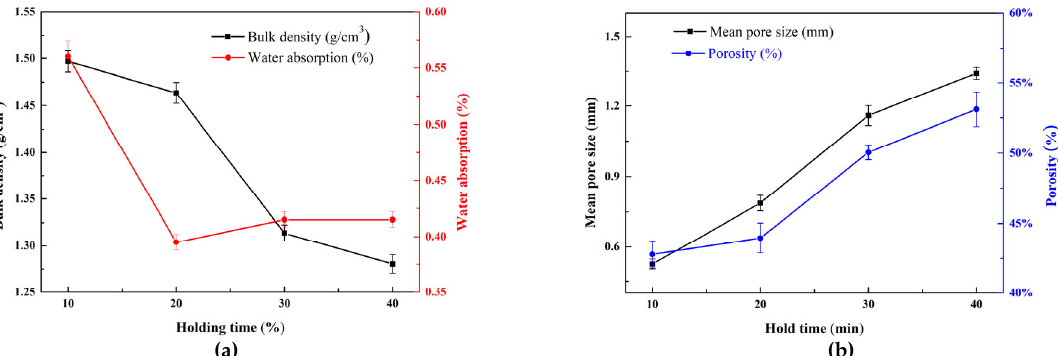
Figure 6. ( a ) Bulk density and water absorption and ( b ) mean pore size and porosity of samples sintered at 1200 °C for different holding times.